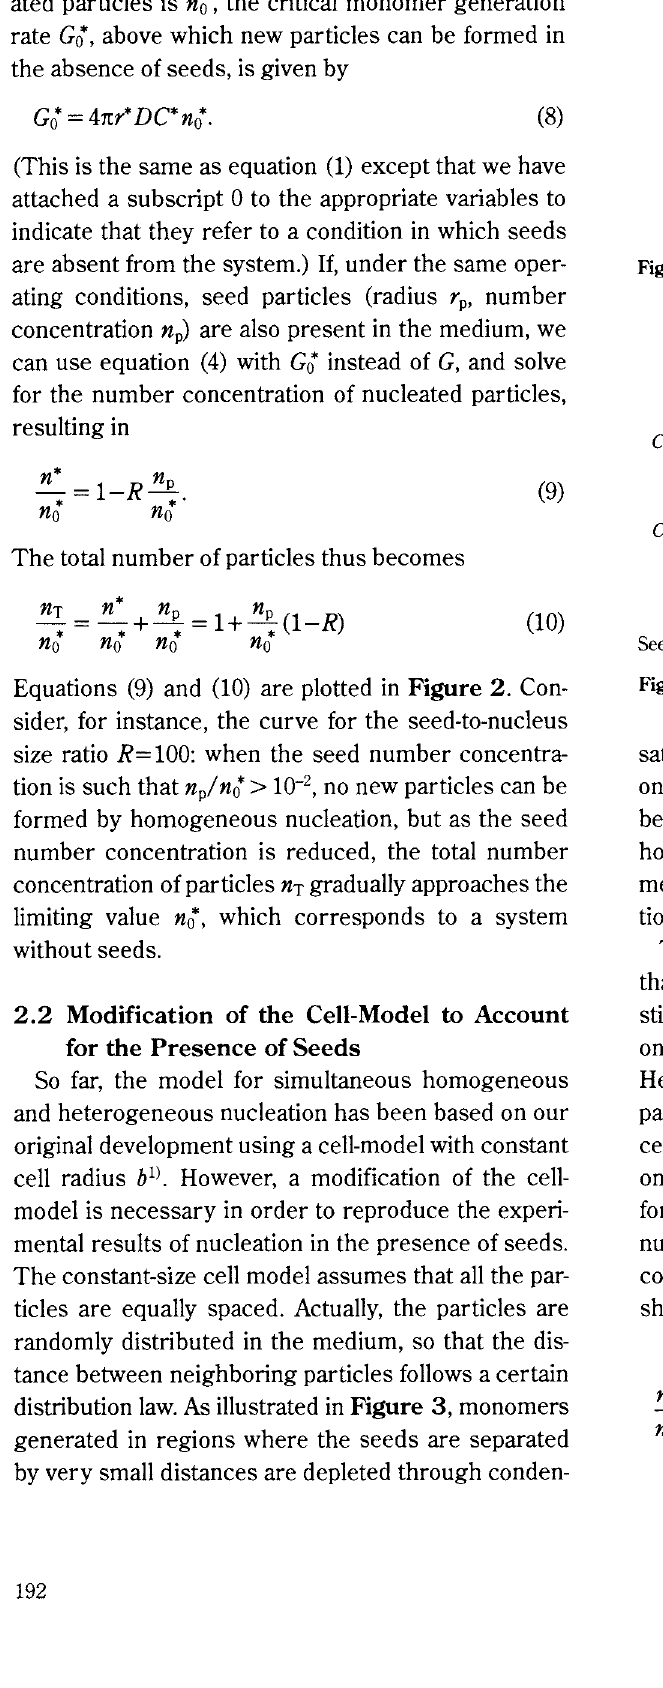
Relationship between total number concentration of parti cles nT and number concentration of seeds np as a func tion of the seed-to-nucleus size ratio R